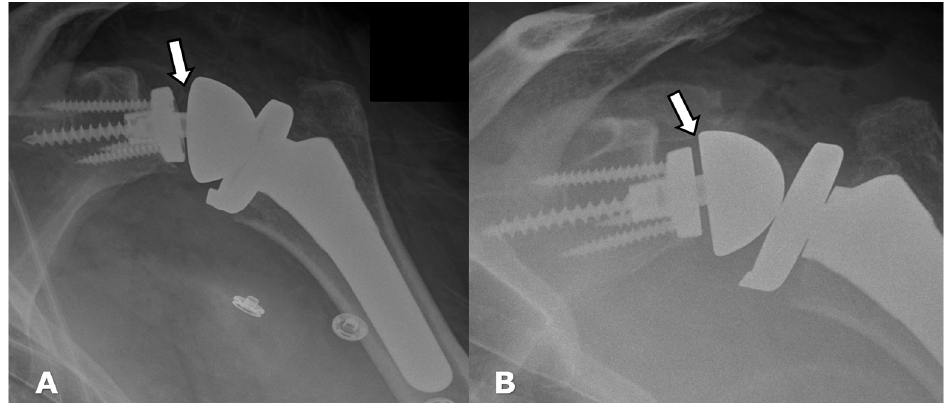
Figure 28. Frontal radiographs. ( A ). Immediate post-operative image following RTSA shows incom- plete seating of the Morse taper into the baseplate, with resulting asymmetric alignment of the glenosphere (arrow). ( B ). Patient returned to the operating room for revision of the hardware, with post-operative image showing improved positioning of the Morse taper into the baseplate and improved glenosphere alignment.